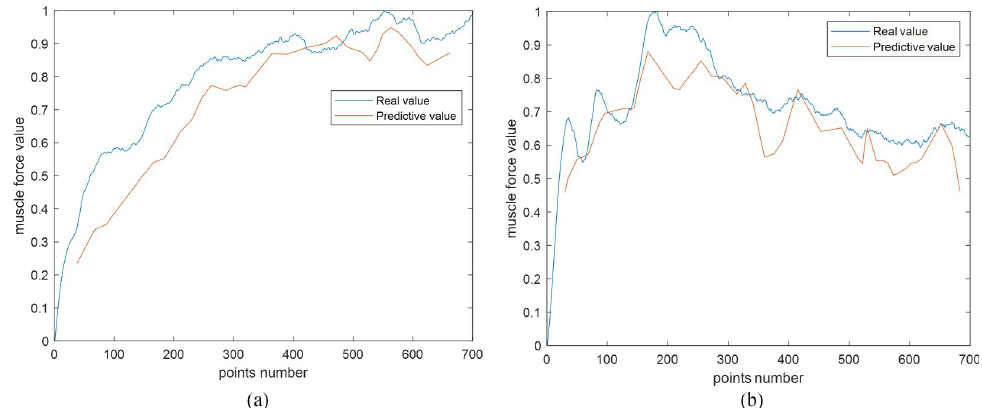
Fig 6. Comparison curves of the real and predictive muscle forces. (a) is the prediction result of experiment data1 in Table 4; (b) presents the results of experiment data2 in Table 4. https://doi.org/10.1371/journal.pone.0272118.g006 shows when the FOS is used as the prediction model, the prediction results of input data that are not processed using the NMFSEMD method are compared with the input data that are processed using the NMFSEMD method. Additionally, Table 4 shows when the NMFSEMD denoising method is used as the preprocessing method, the results of prediction model that using the FOS method are compared with the model that using the LSSVM method. The pre- diction result is evaluated using the MSE value, as shown in Eq (7). Table 4. MSE and its statistical error (mean ± standard error) of prediction results under different prediction models and input data in various experiments. Result of